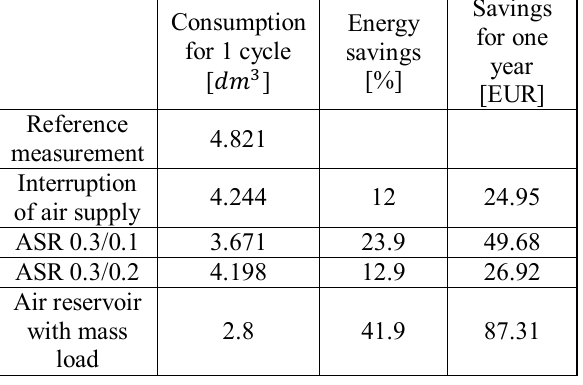
Tab. 5. Energy savings for measured tasks, working pressure 0.3 𝑀𝑃𝑎